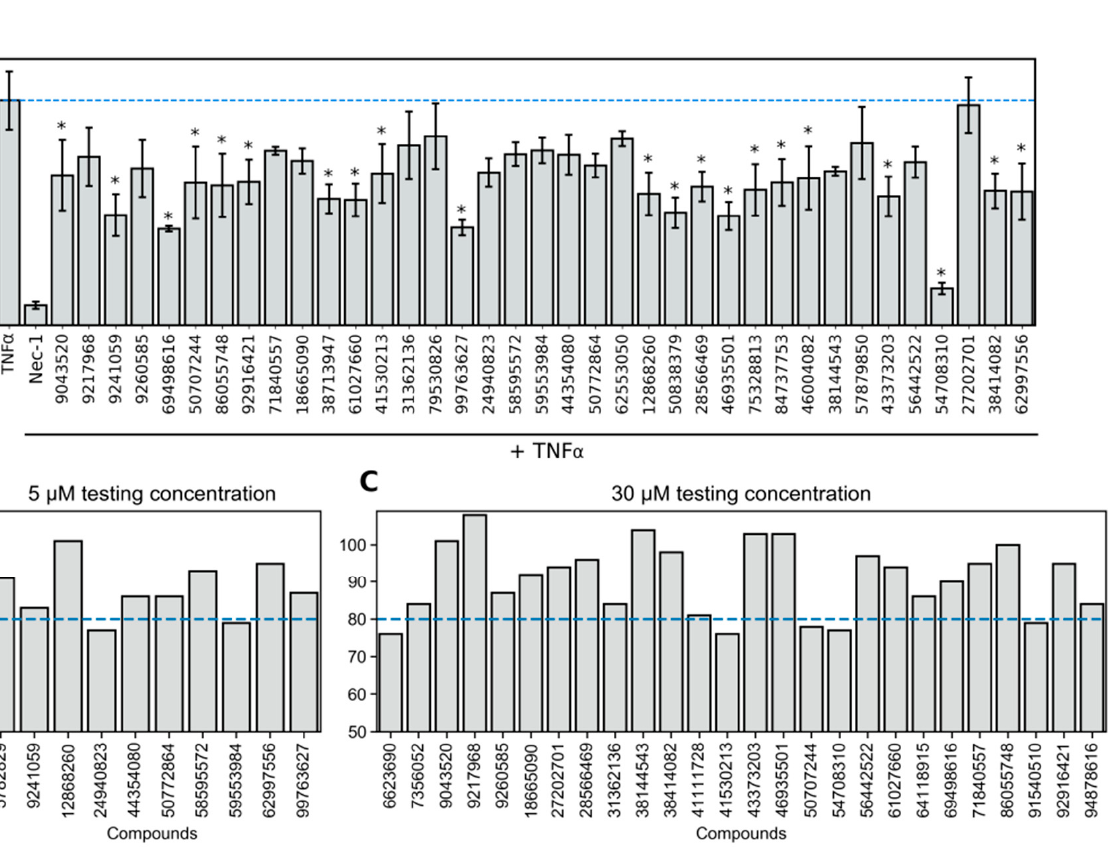
Figure 17. ( A ) Cell death measured by AK release produced under different treatment conditions in L929 cells, expressed as mean and standard deviation. The different cell treatment conditions are listed on the x-axis, which include a vehicle control (DMSO), a negative control (TNF α ), a positive control (Nec-1), and the different test compounds paired with TNF α (N = 37). Of the initial 50 candidates, 3 were initially excluded due to solubility issues and 10 more were later excluded for not allowing reproducible AK release readouts (standard deviation greater than or equal to 30% of the mean), * p < 0.05 vs. TNF α . The remaining hRIPK1 activity was determined in a direct biochemical assay where a few compounds were initially shortlisted for testing at 5 µ M ( B ), and the remaining compounds were later tested at 30 µ M ( C